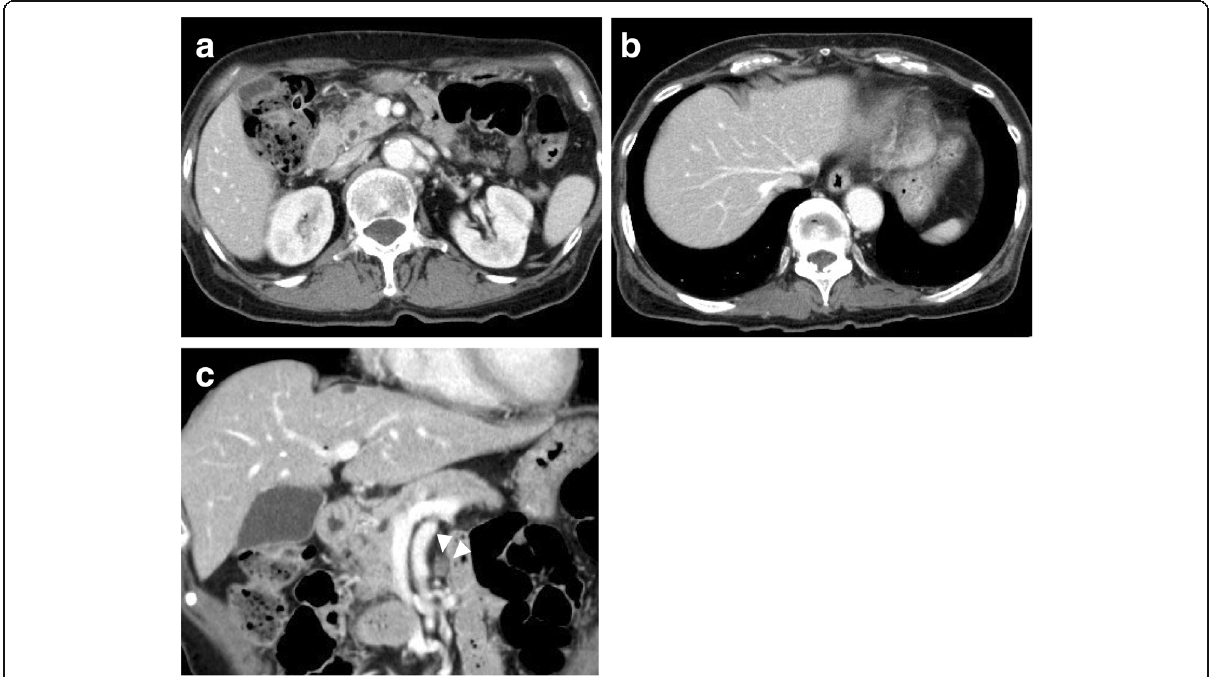
Fig. 4 a , b Abdominal computed tomography after 19 months of chemotherapy showed disappearance of multiple liver tumors. c Chemotherapy also contributed to the reduction in the size of the enlarged lymph nodes around the bile duct and superior mesenteric artery (arrowhead)